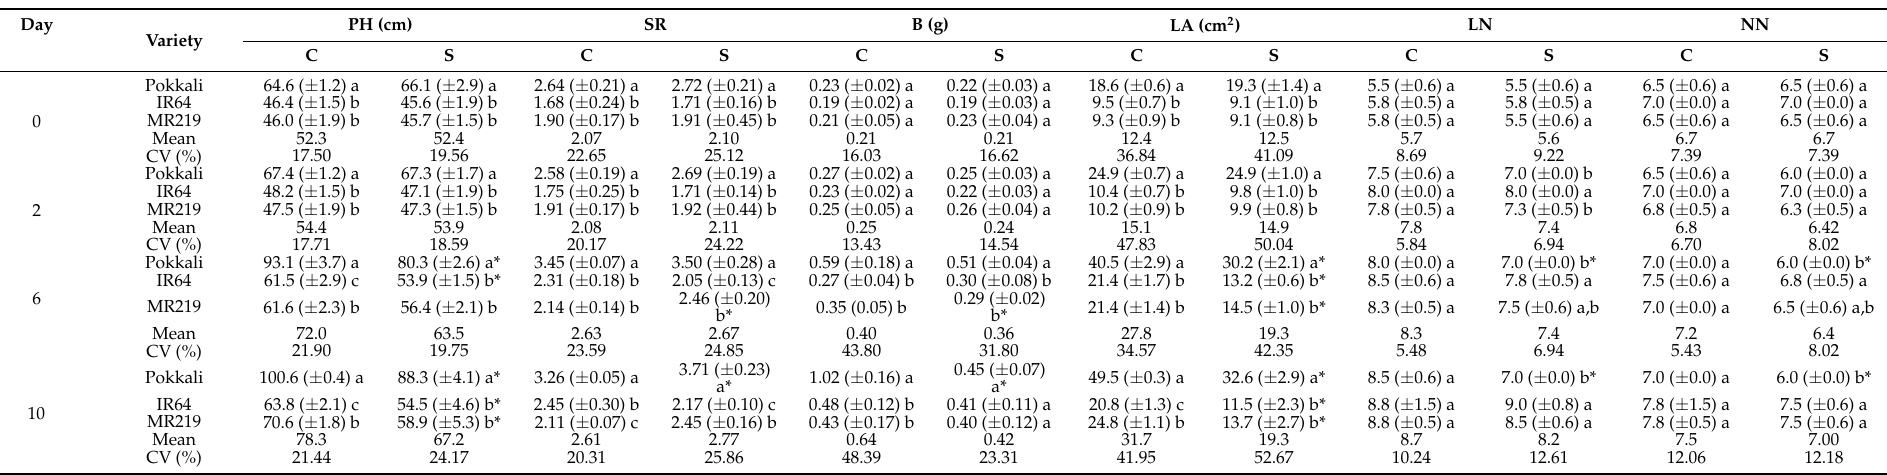
Table 3. Changes in growth parameters of Pokkali, IR64, and MR219 under salinity stress. C = Control, S =